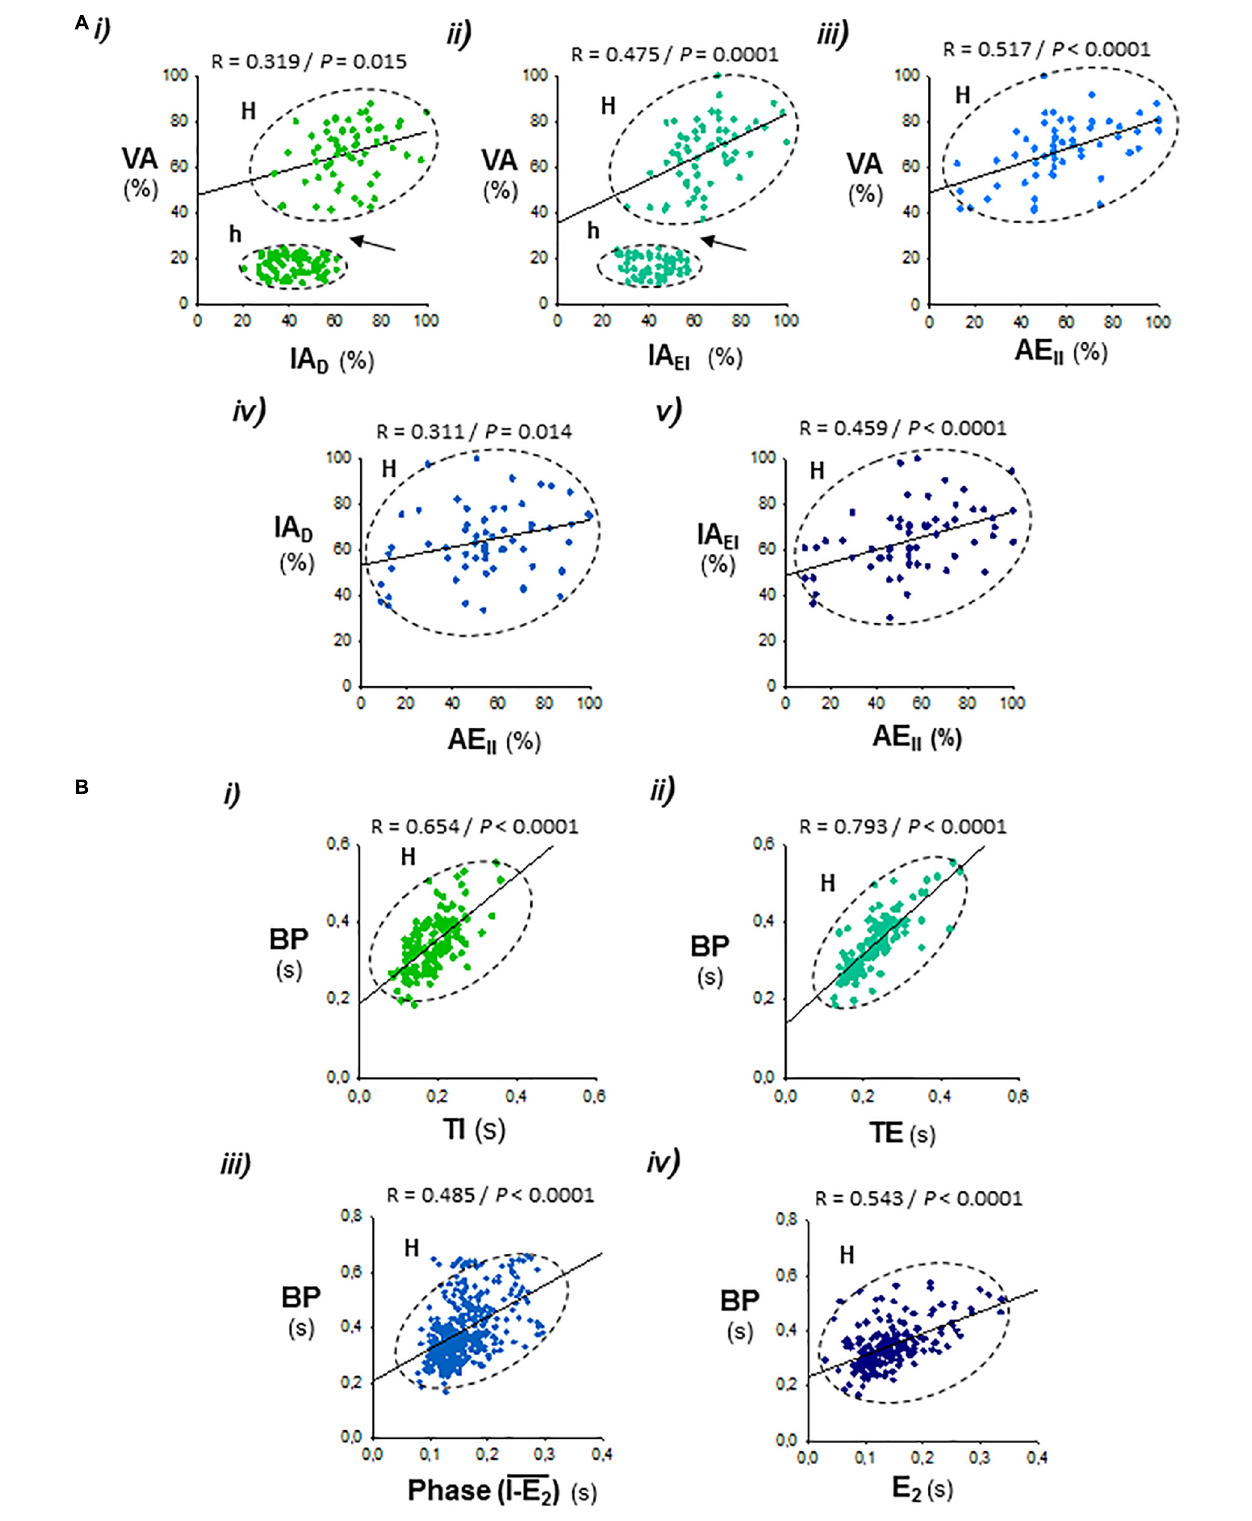
FIGURE4 Correlations between the respiratory parameters during expiratory–inspiratory coupling. Data set from Figure 3 . (A) Positive correlations of the peak intensity of inspiratory and expiratory activities of the diaphragm and external and internal intercostal muscles ( AI D , AI EI , and AE II ) with the amplitude of ventilation ( AV ; i–iii), and the peak intensity of expiratory internal intercostal activity ( AE II ) with the inspiratory diaphragm and external intercostal activities ( AI D , AI EI ; iv,v); note the abrupt jump of AV in the hypopnea–hyperpnea transitions ( h and H , arrows in i and ii). (B) Period of the breathing cycle ( BP ) correlates positively with the inspiration and expiration time ( TI, TE ; i,ii), the phase of occurrence of active expiration within the respiratory cycle, defined by the interval between the starting of the inspiratory ramp and the beginning of active expiration ( I-E 2 ; iii), and with the duration of active expiration ( TE 2 ; iv). R , Pearson’s correlation coefficient; P , level of statistical